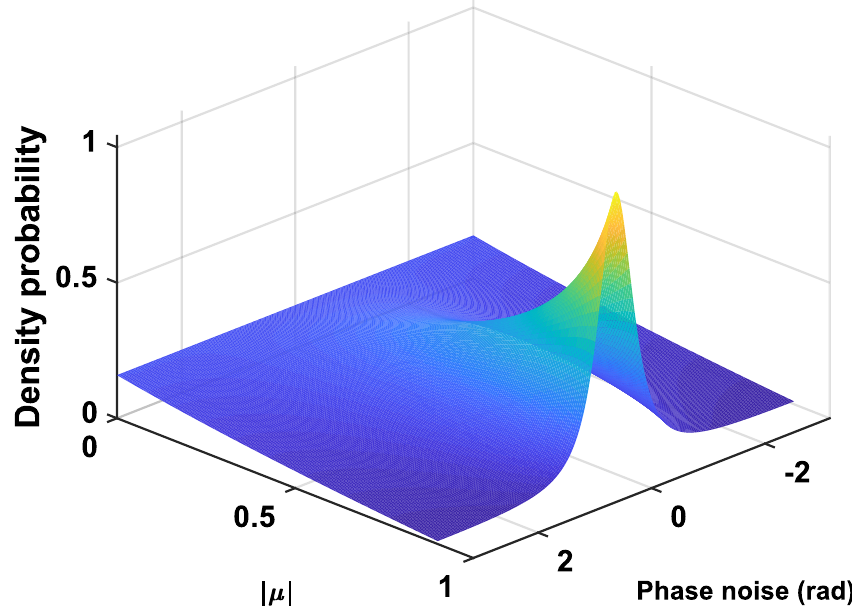
Figure 7. Map of the probability density functions of the speckle noise for different values of the modulus of the coherence factor | µ |